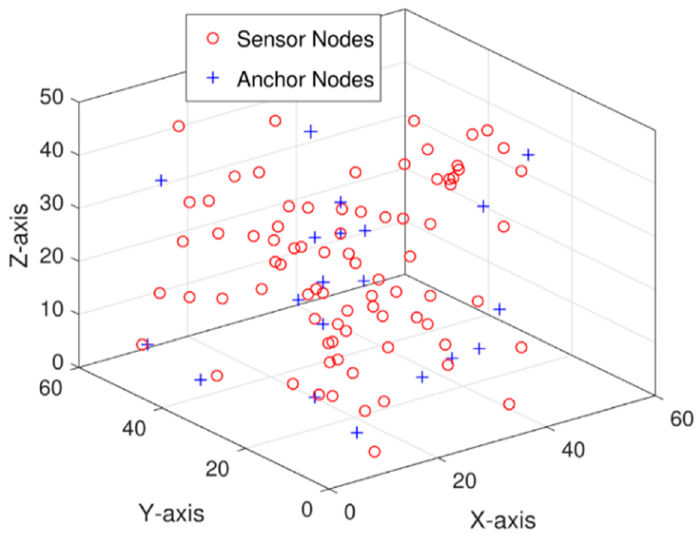
Figure 9. Deployment of sensor nodes in 3D for the proposed underwater wireless sensor network.